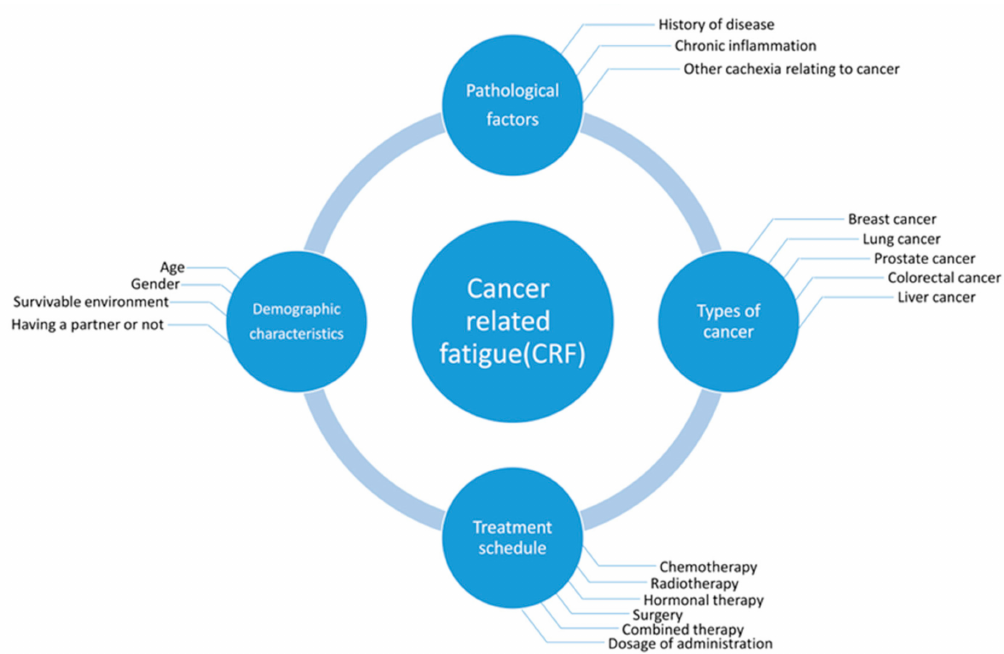
Figure 1. Cancer-related fatigue (CRF) is associated with various risk factors. The predominant factors are demographic characteristics, pathological factors, the types of cancer, and anti-cancer treatment